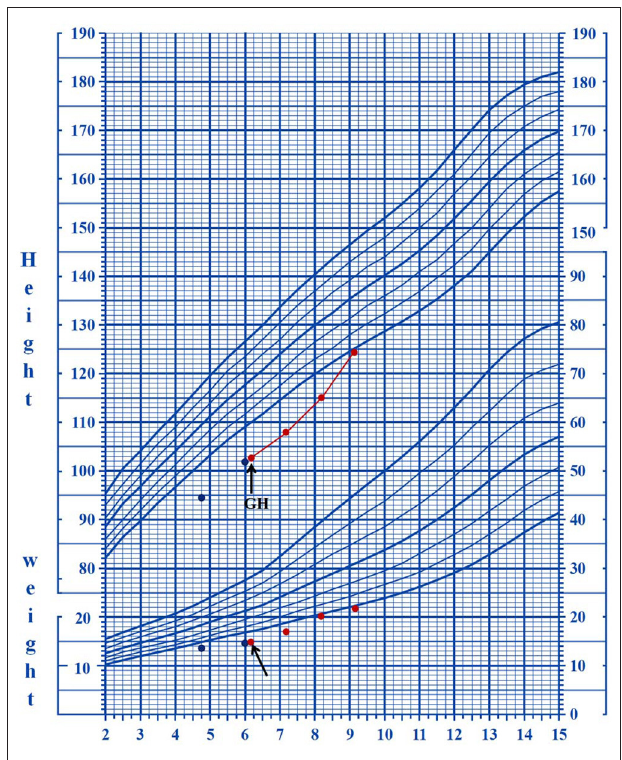
FIGURE 1 | The growth curves of patient four who underwent rhGH treatment. The arrows indicate the starting date of the